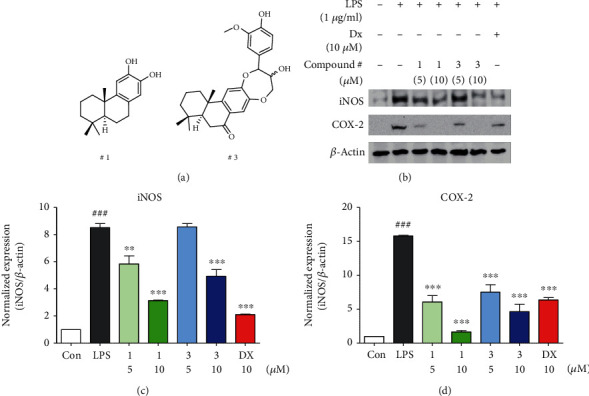
Compounds 1 and 3 showed anti-inflammatory effects through inhibiting iNOS and COX-2. (a) Chemical structure of compounds 1 and 3. (b) Compounds 1 and 3 decreased iNOS and COX-2 protein expression levels in LPS-induced RAW264.7 cells. (c, d) Relative ratio of iNOS and COX-2 versus β-actin was measured using densitometry, and dexamethasone was used as positive control. These graphs represented that compounds 1 and 3 dose dependently inhibited iNOS and COX-2 levels in immunoblot analysis. Cells were pretreated with each compound for 2 h and stimulated with LPS (1 μg/mL) for 16 h. Immunoblot analysis performed a triplicate test, and results are expressed as means ± SEM. An unpaired Student t-test was used for statistical analysis. ###p < 0.001, ∗∗p < 0.01, and ∗∗∗p < 0.001 versus LPS.